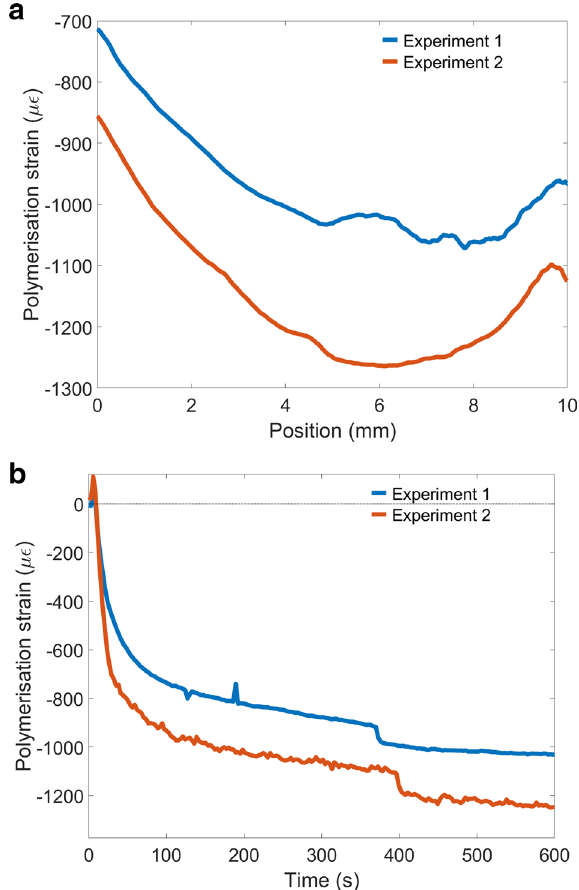
Figure 3. ( a ) PS strain profile of the dental composite measured using CFBG sensor, ( b ) PS strain response at 5 mm location of the dental composite specimen measured by the